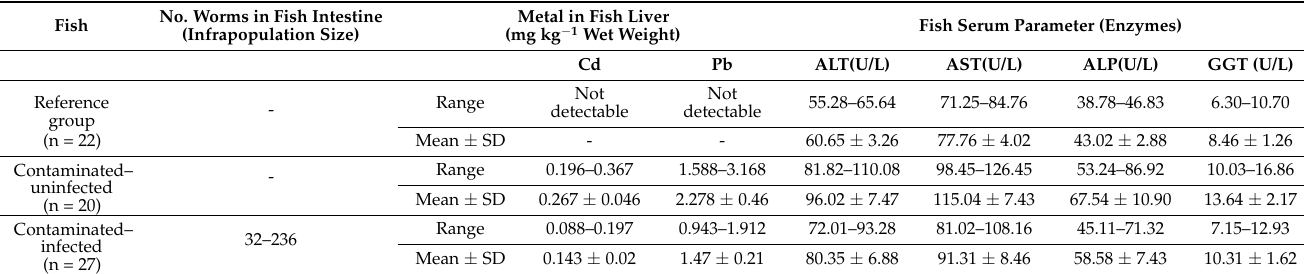
Table 2. Cd and Pb concentrations and levels of serum liver enzymes (ALT, AST, ALP and GGT) in the reference group, and in the contaminated–uninfected and contaminated–infected individuals of the fish Siganus rivulatus . Fish No. Worms in Fish Intestine (Infrapopulation Size)